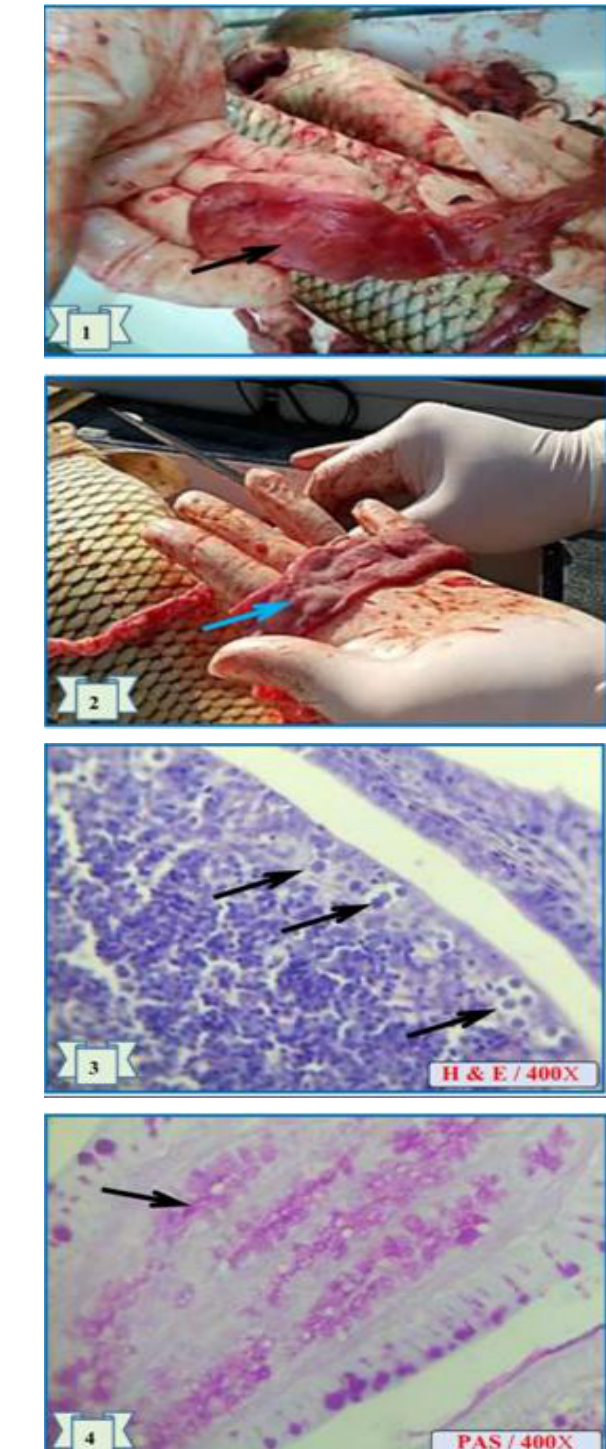
Figure, 4: Spring viremia of common carp. Grossly [1] there is exophthalmia (arrow) and pin point hemorrhage on fish body (arrow), also [2] there is pseudodiphtheric membrane in abdominal cavity with hemorrhagic exudate. Microscopically [3] there is necrosis, sloughing and fusion of intestinal villi (arrow), [4] there is vacuolar degeneration around central vein (arrow) with hemorrhage in hepatic tissue (arrow) and infiltration of inflammatory cells (arrow) in portal area.